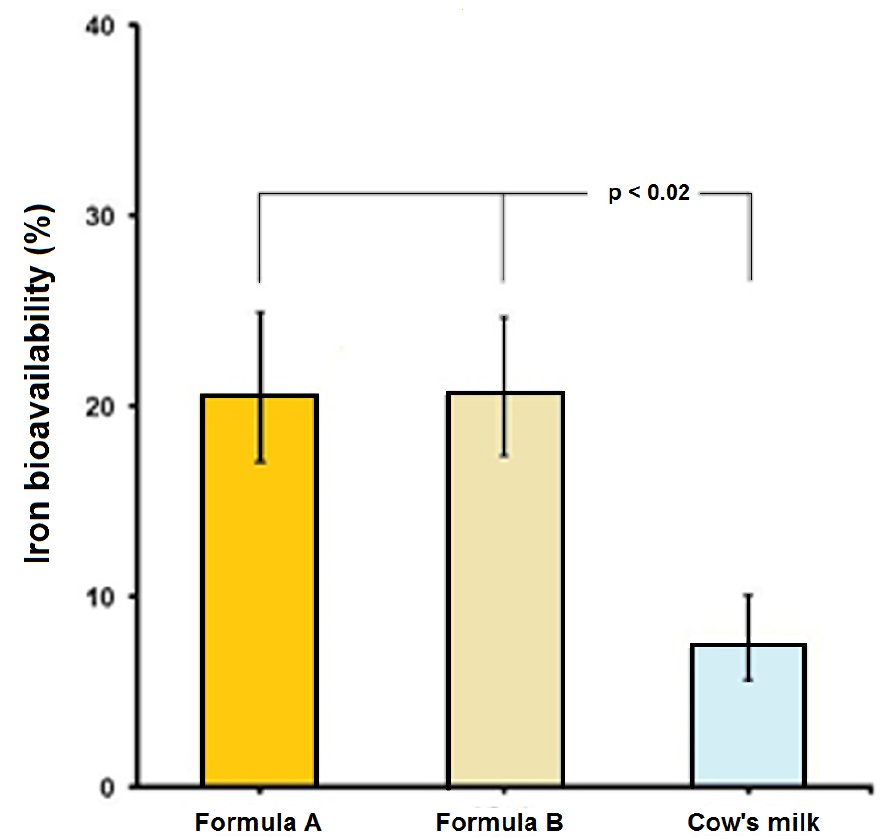
Figure 1. Iron bioavailability of Formula A, Formula B and cow’s milk. The column shows the geometric means corrected to 40% of reference dose and bar shows the ± 1 SEM.